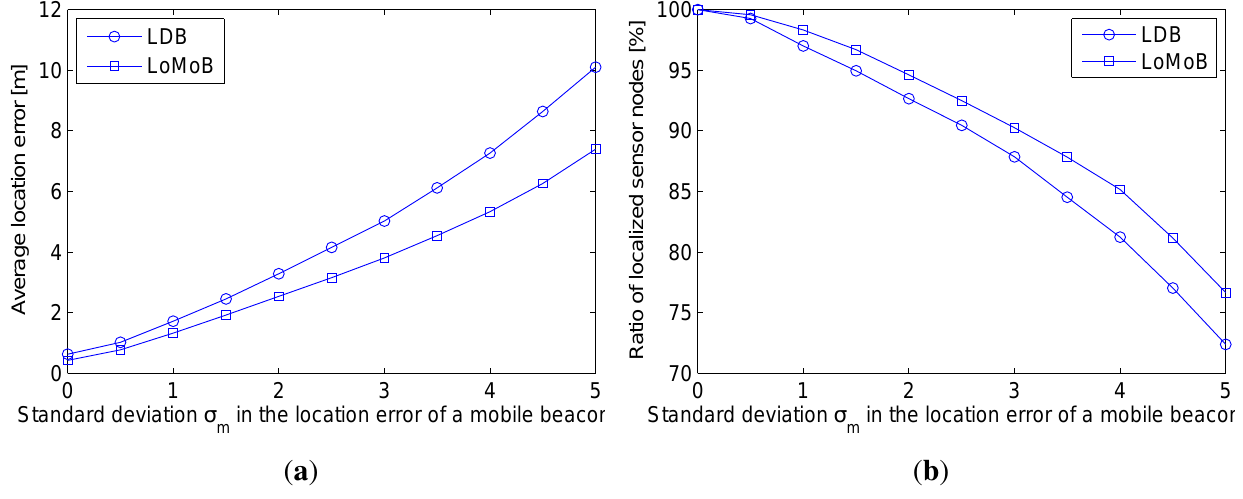
Figure 10. Comparison between simple mean and weighted